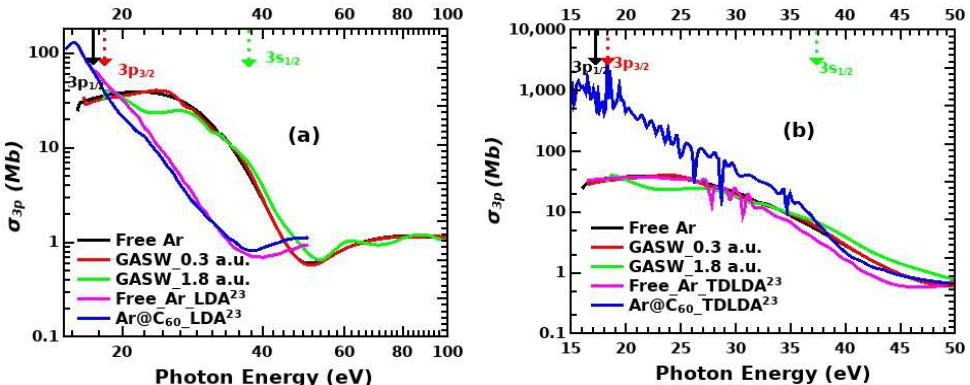
Figure 2. The RRPA photoionization cross-section of the 3p orbital of free and confined Ar is compared with ( a ) LDA [23] and ( b ) TDLDA [23] results. Vertical arrows indicate the threshold values of the corresponding subshells used in the RRPA.